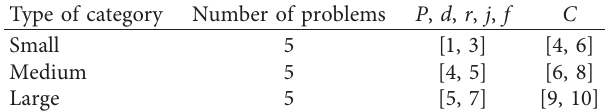
Table 3: Details of the designed problems.